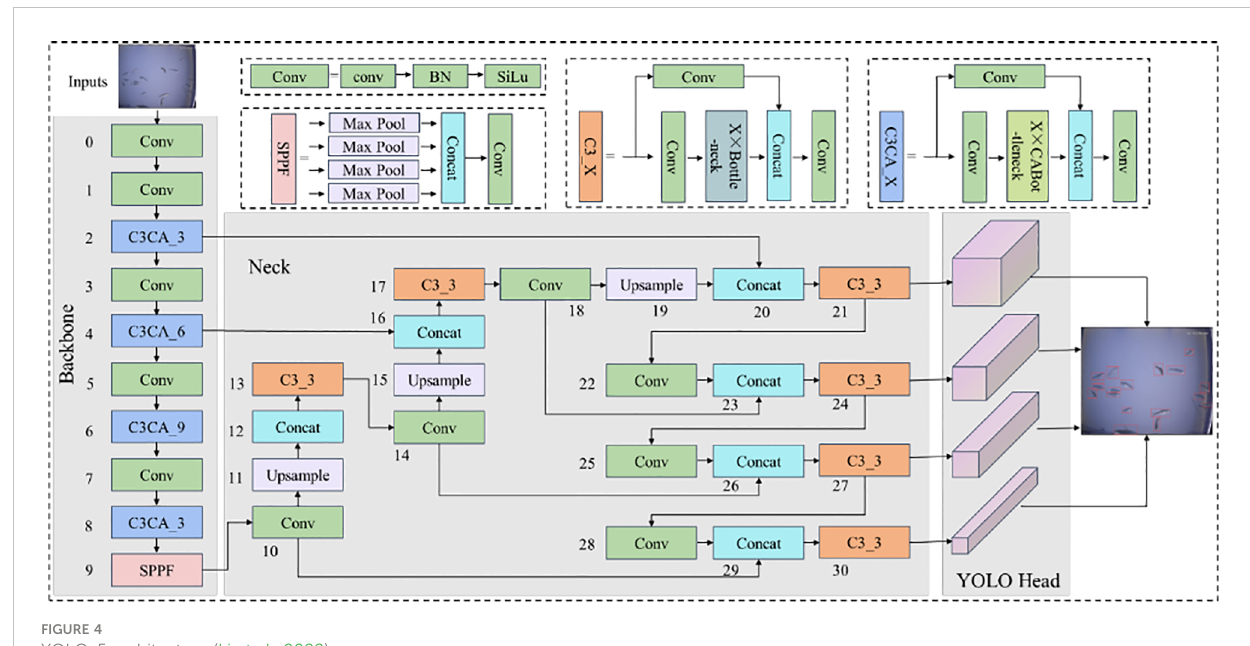
FIGURE 4 YOLOv5 architecture (Li et al.,